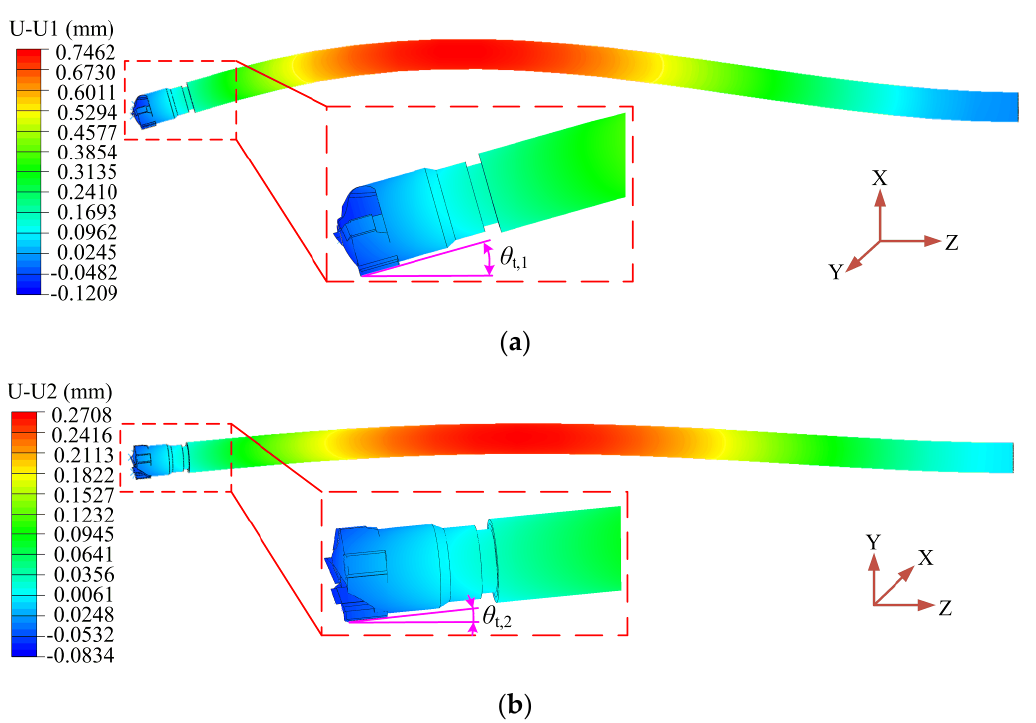
Figure 8. The displacement nephogram of the drilling tube deformation during BTA deep hole machining: ( a ) along the first guide pad; ( b ) along the second guide pad.